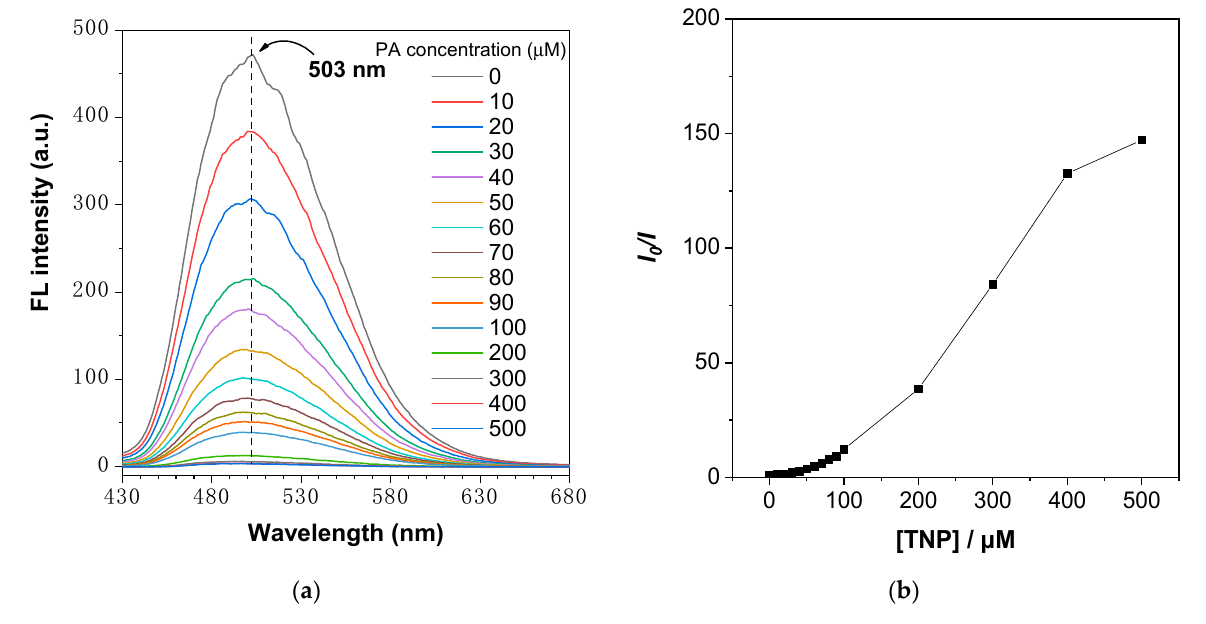
Figure 7. ( a ) PL spectra of P 7 in THF/H 2 O (90%) solution with different amounts of PA. ( b ) Stern– Volmer plot of I 0 / I vs. PA concentration in THF/H 2 O (90%) solution. I 0 and I are the peak PL intensity at [TNP] = 0 mM and a non-zero concentration. [M]: 10 μ M, λ ex = 387 nm.